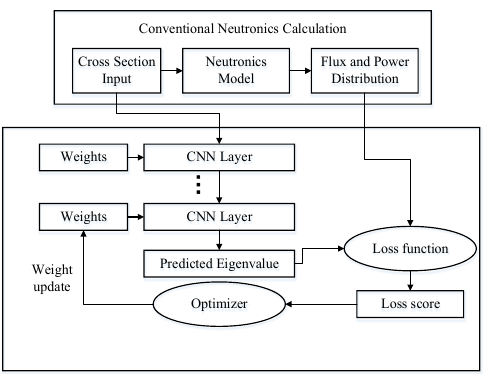
Figure 1. The general framework of the deep learning model applied to neutronics